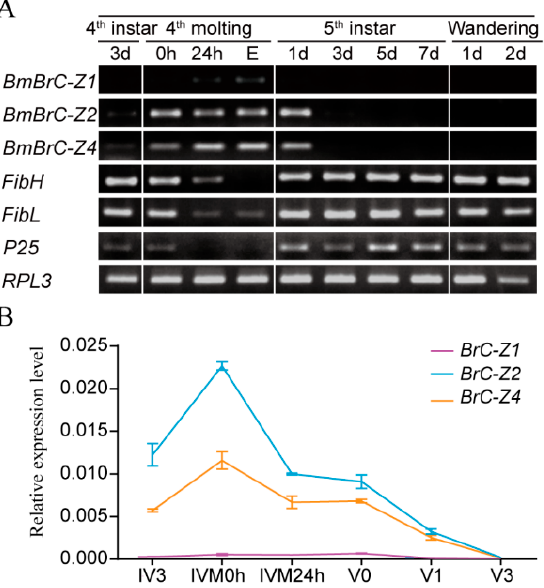
Figure 1. Expression patterns of BmBrC-Zs and fibroin genes in Bombyx mori. ( A ). Expression levels of BmBrC-Zs and fibroins in the PSG from 3rd day of the 4th instar to the 2nd day of the wandering stage by semi-RT-PCR analysis; ( B ) relative expression level of BmBrC-Zs in PSG at 3rd day of the 4th